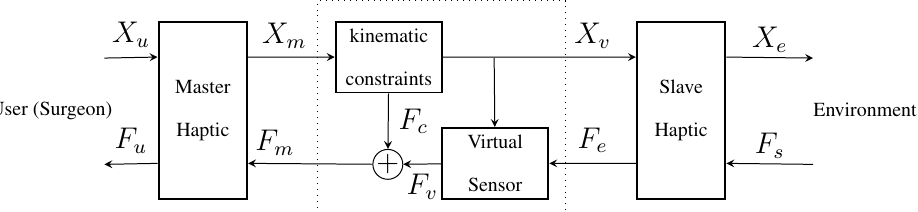
Figure 3. General scheme of the virtual prototyping system, where a virtual instrument, between the master and the slave haptics, is implemented by the motion constraints and virtual sensor